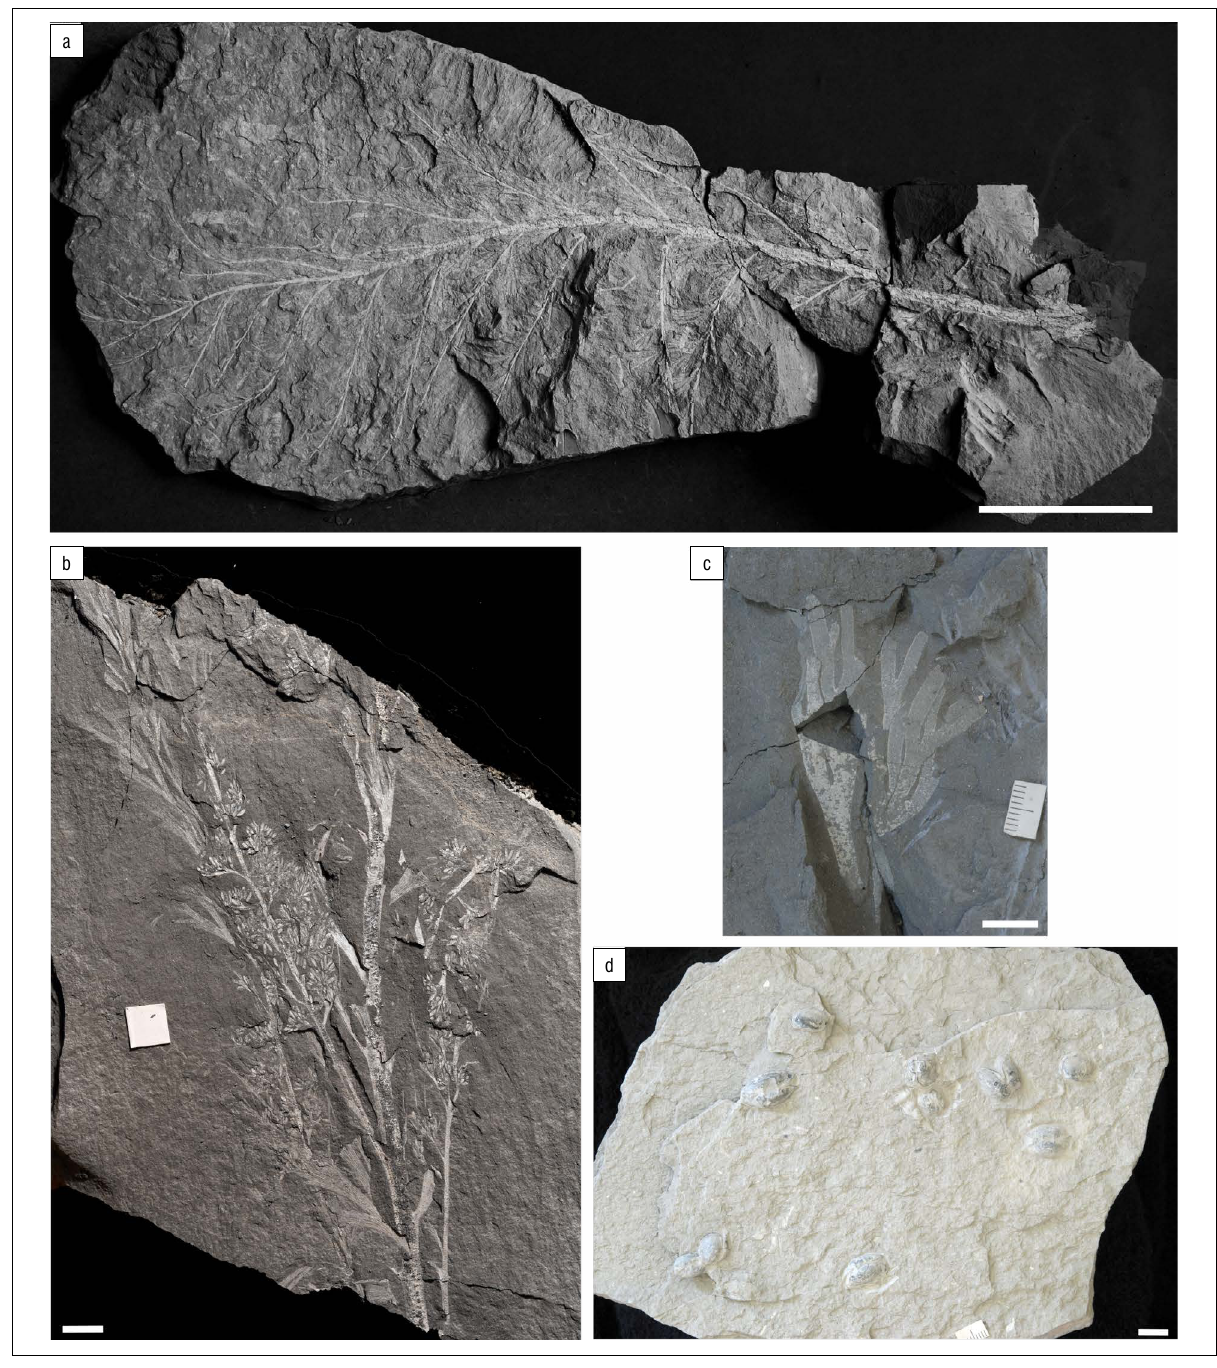
Figure 5: Fossil remains from Coombs Hill. (a) A near-complete lateral branch system of Archaeopteris notosaria, AM 7710a (scale bar = 10 cm). (b) Fertile branch of A. notosaria, AM 7714a (scale bar = 1 cm). (c) Putative marine alga, AM 7717 (cf. Hungerfordia fionae ) (scale bar = 1 cm). (d) Articulated bivalve shells on a bedding plane, AM 7718a (scale bar = 1